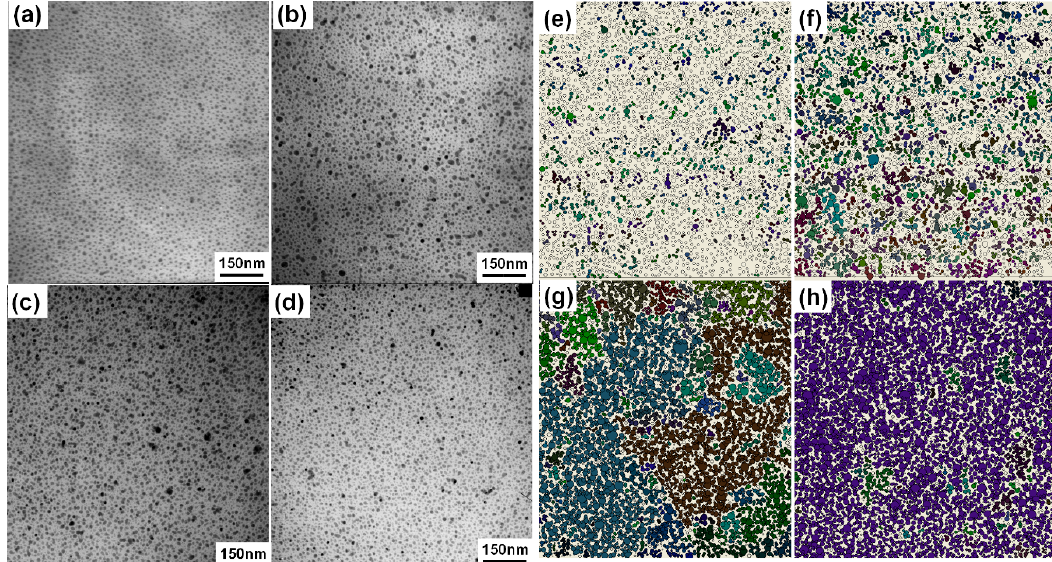
Figure 4. TEM images of the Pd NP films with deposition time of ( a ) 100 s, ( b )175 s, ( c ) 350 s and ( d ) 650 s and the corresponding digitalized NP location mapping ( e – h ), with each percolation cluster being marked with different colors.